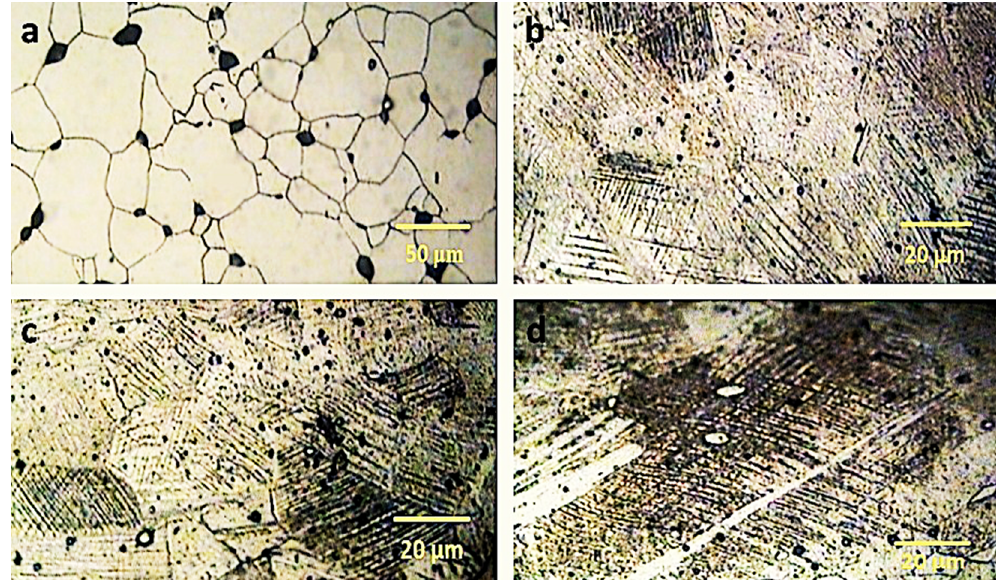
Figure 1. Light optical micrographs of Ti-bearing 201L steel in ( a ) non-deformed state and after ( b ) 10% ( c ) 15% and ( d ) 20% thickness reductions.